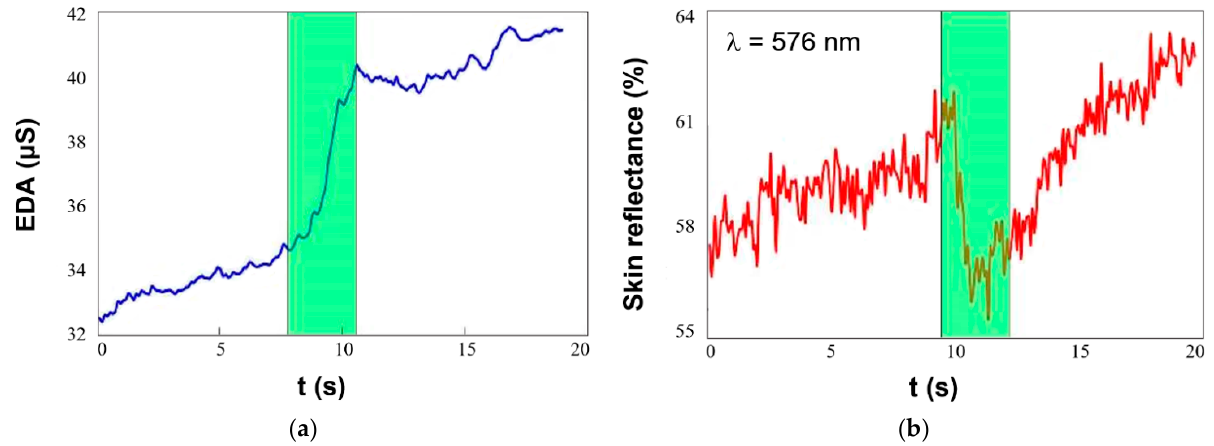
Figure 6. Simultaneous electro-optical measurement of stress: ( a ) EDA, ( b ) skin reflectance.